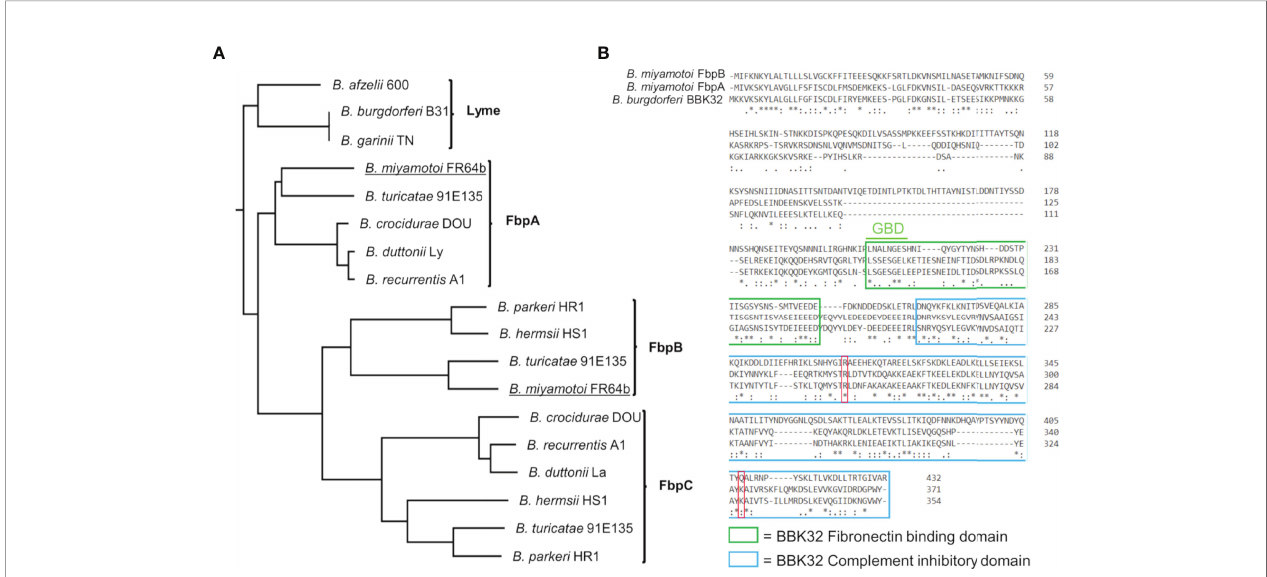
FIGURE 1 | B. miyamotoi encodes two orthologous genes to B. burgdorferi BBK32. (A) BBK32 orthologs are found in relapsing fever (RF)-associated and B. miyamotoi spirochetes and are denoted FbpA, FbpB, and FbpC (41). B. miyamotoi FR64b FbpA and FbpB are underlined. (B) An alignment of B. miyamotoi strain FR64b FbpA and FbpB to B. burgdorferi strain B31 BBK32 shows differences of the amino acid sequences within the fi bronectin binding (green box) and complement inhibitory domains (blue box). The gelatin-binding domain (GBD) of BBK32 is denoted. The key residues R248 and K327 of BBK32 involved in complement C1r binding are indicated by a red box. * conserved, : strongly similar, . weakly